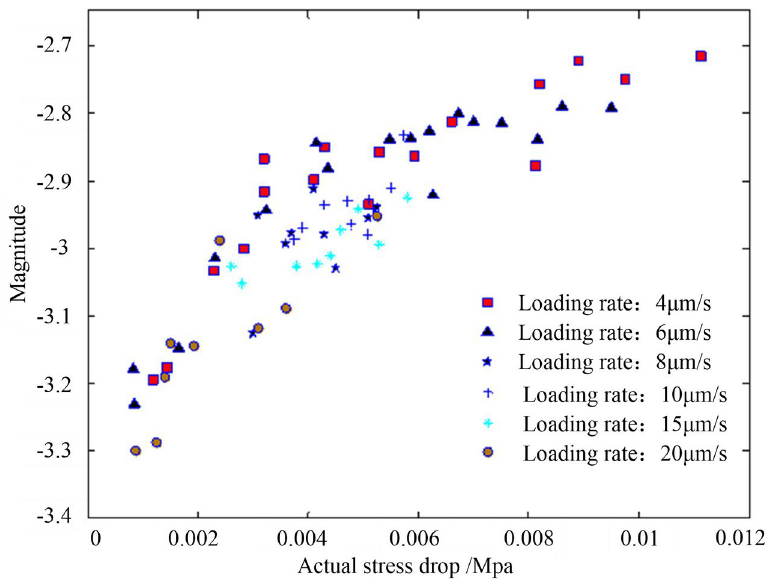
Fig 9. The relationships between the magnitude and the actual stress drop at different loading rates.